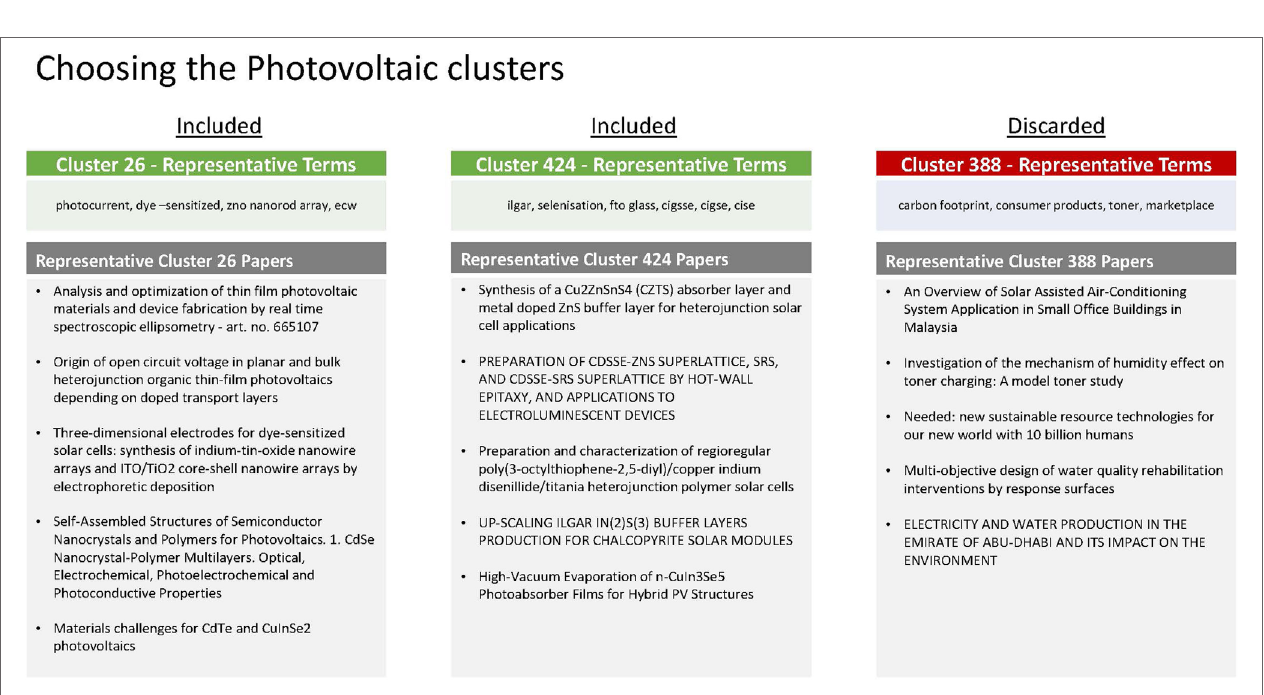
FigUre 9 | Material–application pairing matrix from the U.S. Department of Energy Critical Materials Strategy Report, December 2011. These classifications were used to validate the results from the clustering algorithms.